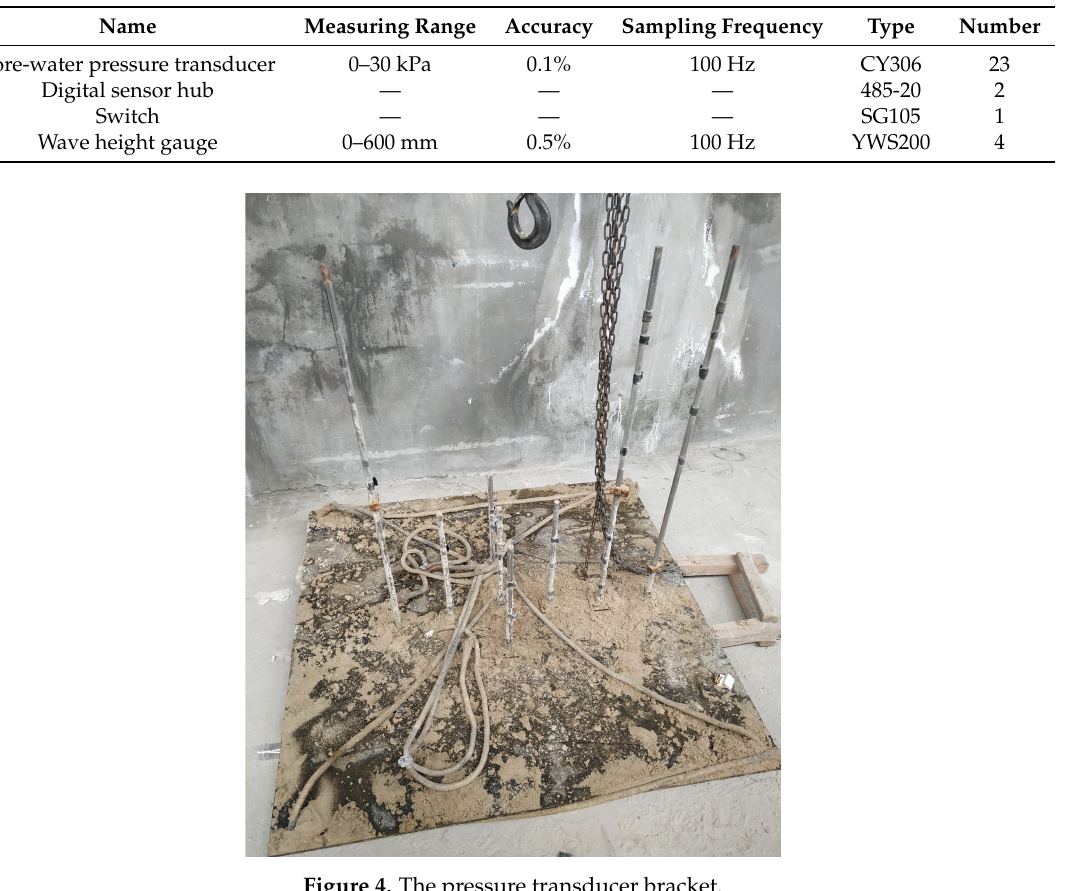
Table 1. Measuring equipment and specifications.